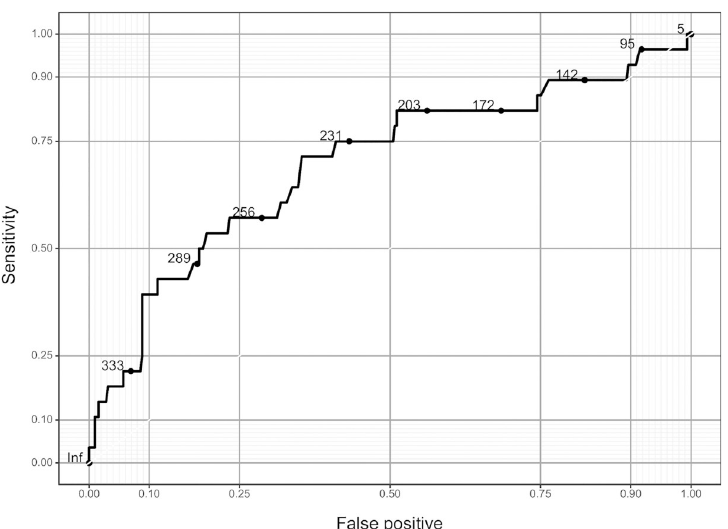
Fig 4. Area under the receiver-operating characteristic curve for the PRU only model. Abbreviations: PRU, P2Y 12 reaction units.